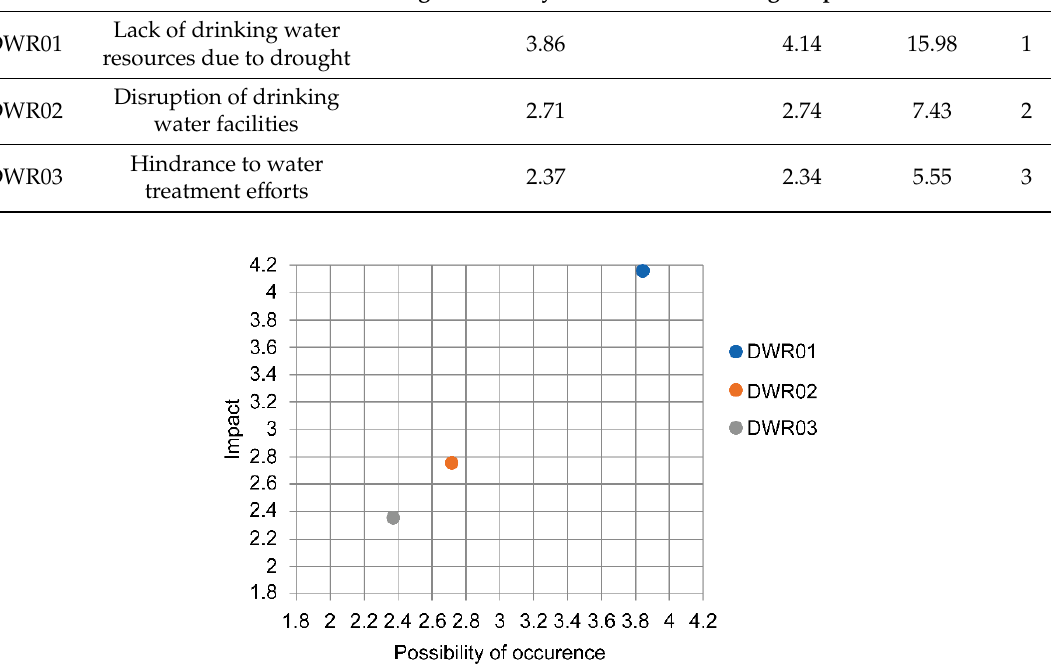
Table 4. Rank of DWR (drinking water resources) risk factors.